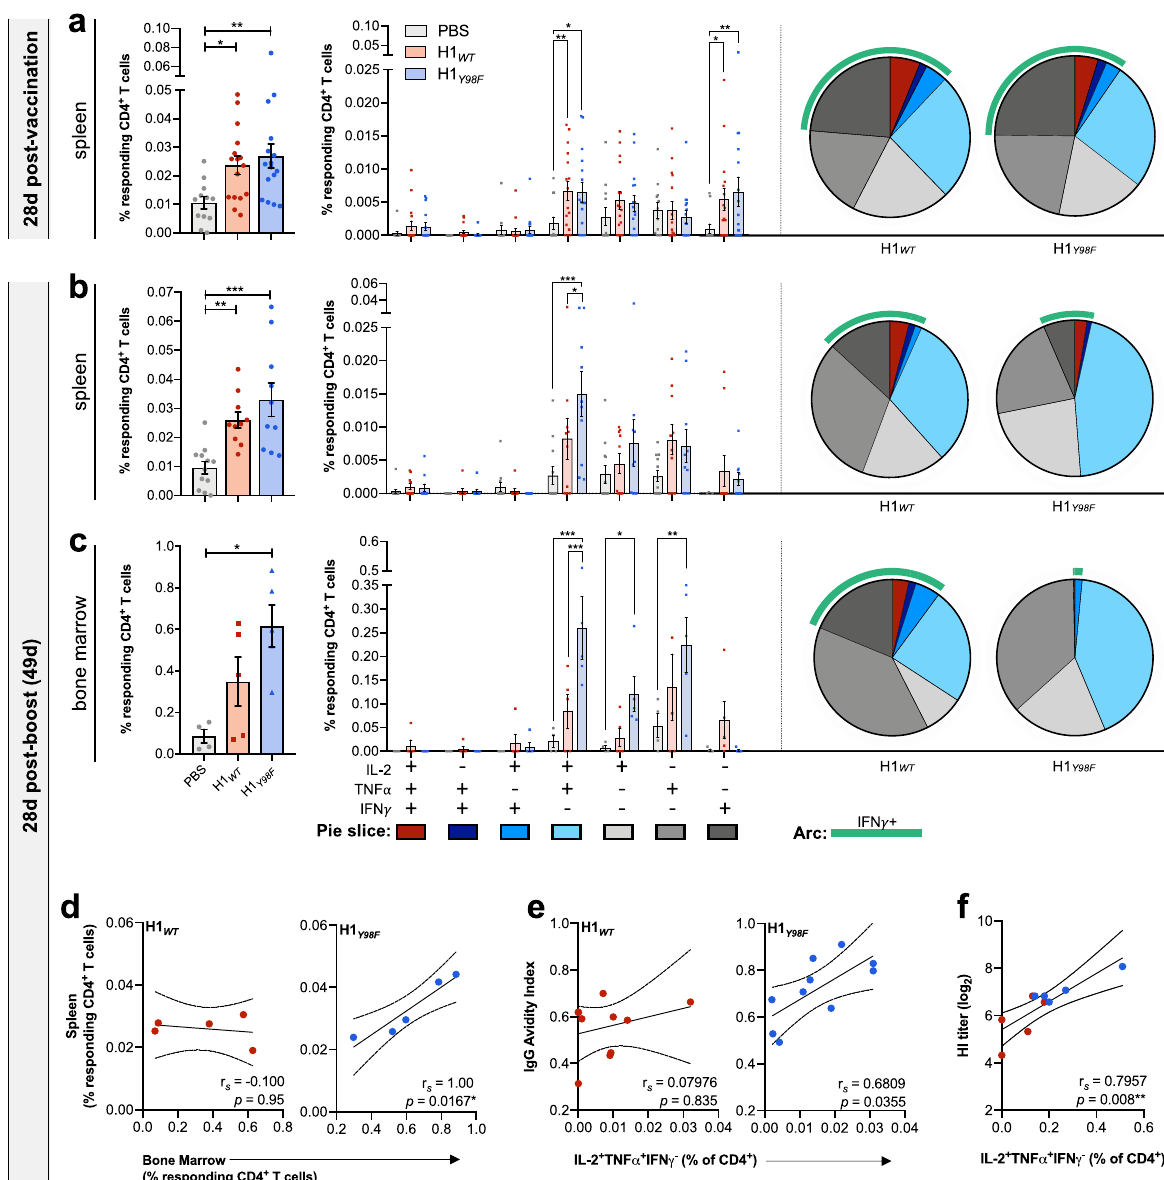
Fig. 4 H1 Y98F -VLP elicits robust CD4 + T cell responses with enhanced recruitment of antigen-speci fi c CD4 + T cells to the bone marrow. Splenocytes and BM immune cells were stimulated for 18 h with 2.5 µg/ml H1 WT -VLP. Flow cytometry was used to quantify H1-speci fi c CD4 + T cells in a splenocytes isolated at 28 days post-vaccination (3 µg) and in b splenocytes and c BM immune cells at 28 days post-boost (0.5 µg/ dose). Background values obtained from non-stimulated samples were subtracted from values obtained following stimulation with H1 WT -VLP. a – c The left panel shows the mean frequency (±SEM) of CD4 + T cells expressing CD44 and at least one of IL-2, TNF α or IFN γ . The right panel shows the individual cytokine signatures of responding CD4 + T cells obtained by Boolean analysis. Color-matched pie charts depict relative distributions of cytokine-producing CD4 + T cell populations and IFN γ + populations are highlighted by a green arc. Statistical signi fi cance was determined by Kruskal – Wallis test with Dunn ’ s multiple comparisons (total response) or two-way ANOVA with Tukey ’ s multiple comparisons (cytokine signatures) (* p < 0.033, ** p < 0.01, *** p < 0.001). Spearman ’ s rank correlation technique was applied to evaluate the relationship between ( d ) the frequency of H1-speci fi c CD4 + T cells in the spleen and BM, e the frequency of IL-2 + TNF α + IFN γ - CD4 + T cells in the spleen and IgG avidity index (4 M urea) and f the frequency of IL-2 + TNF α + IFN γ − CD4 + T cells in the BM and HI titer (* p < 0.033, ** p <